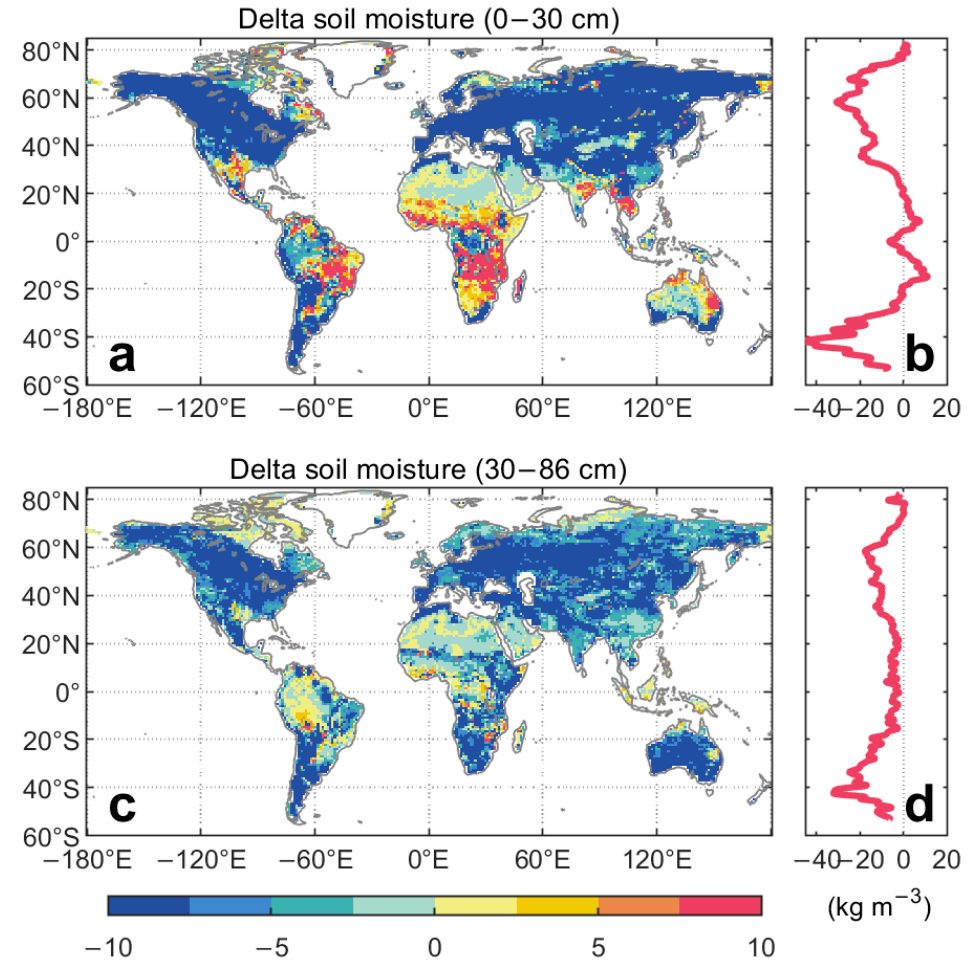
Figure 3. Spatial distributions of the PHS-induced (Delta) changes in soil moisture in the shallow (0–30 cm) and deep layers (30–80 cm). The pixels in the left panels ( a , c ) represent temporally averaged values during 1850–2010 and the vertical thick lines in ( b , d ) represent the latitudinal mean in corresponding left panels.